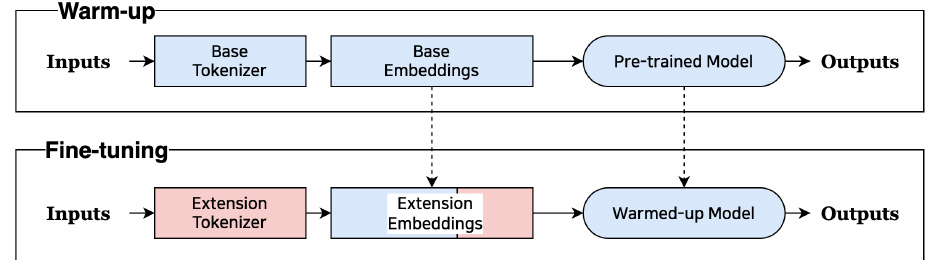
Figure 1. Concept of the entire process. The blue color displays the warm-up step, and the red color shows the expansion token and the fine tuning. The solid line shows the training progress, and the dotted line represents the use of embeddings and